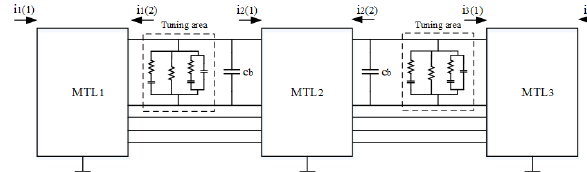
Fig. 2. Circuit diagram of MTL hybrid lumped parameter